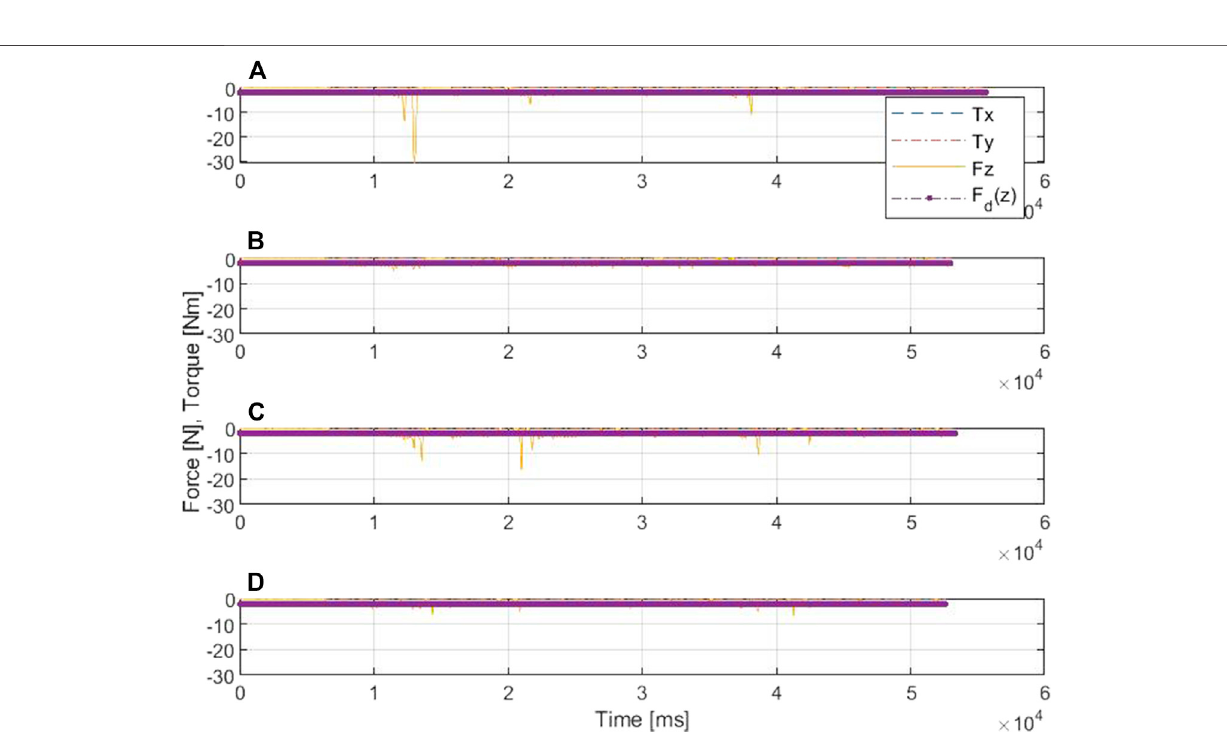
Frontiers in Robotics and AI |